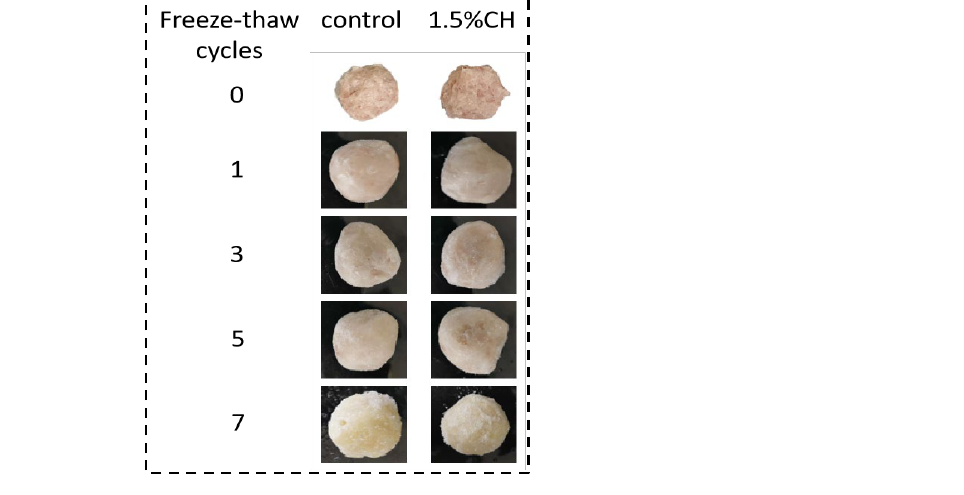
Figure 1. Sample diagram of frost production on the surface of the quick-frozen fish